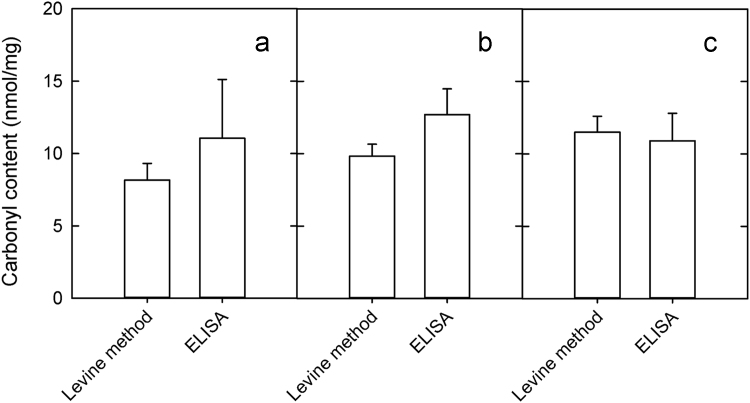
Determination of carbonyl content in animals that underwent autotransfusion (n = 5) (a), animals treated with PEG-Hboxy (n = 3) (b) and animals treated with PEG-Hbdeoxy (n = 6) (c). The error bars are the standard error of the mean.